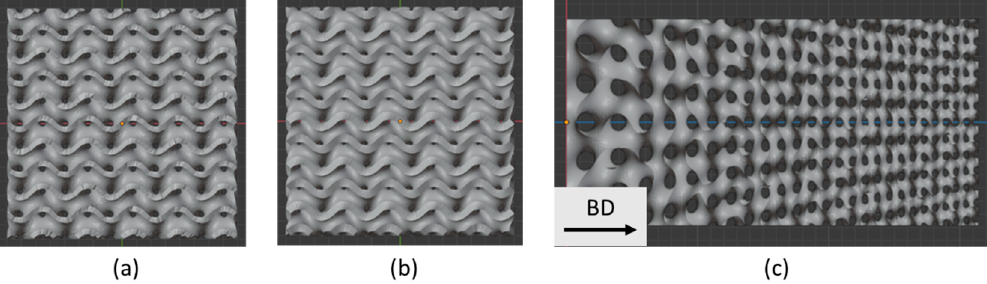
Figure 1. Models of the gyroid TPMSS with nominal WT of 0.4 mm ( a ), 0.6 mm ( b ), and gyroid-based functionally graded porous scaffold (FGPS) ( c ). BD indicates the build direction during manufacturing.